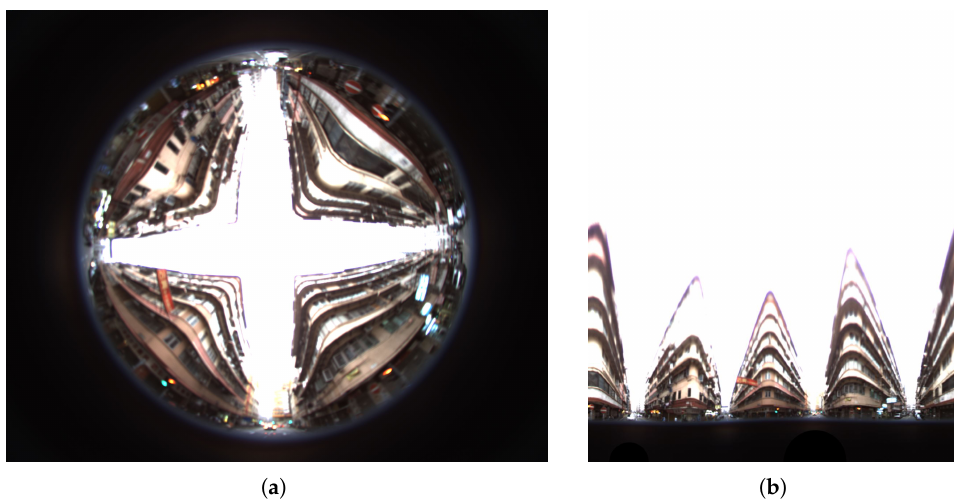
Figure 5. Results of omnidirectional image rectification. ( a ) Image captured by the omnidirectional camera. ( b ) Image after